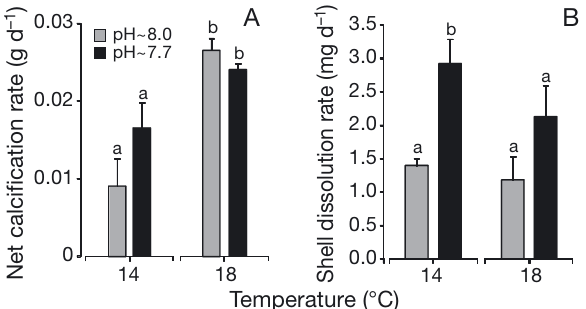
Fig. 5. (A) Net calcification rate (mean ± SE) of Argopecten purpuratus reared at 2 temperatures and 2 nominal pH levels in seawater. (B) Dissolution rate (mean ± SE) of dead shells of the scallops exposed to the same experimental conditions. These rates were estimated based on the differ- ence between initial and final measurement after the 18 d experimental period. Different letters indicate significant differences among treatments (n = 5) using a post hoc Tukey